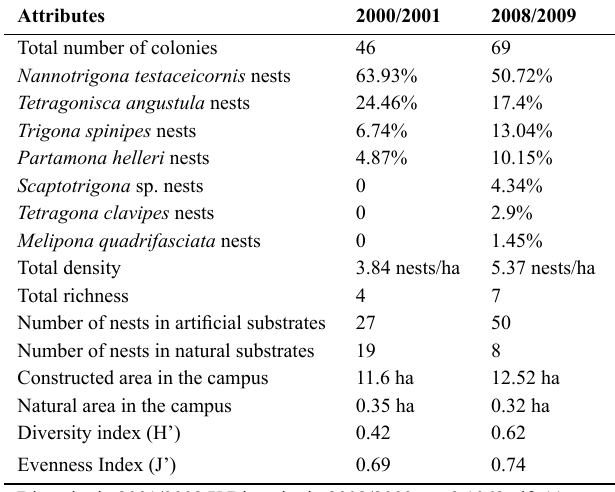
Table 3. Comparison of nesting attributes of stingless bees in the campus of the Federal University of Juiz de Fora, southeastern Brazil, between 2000/2001 and